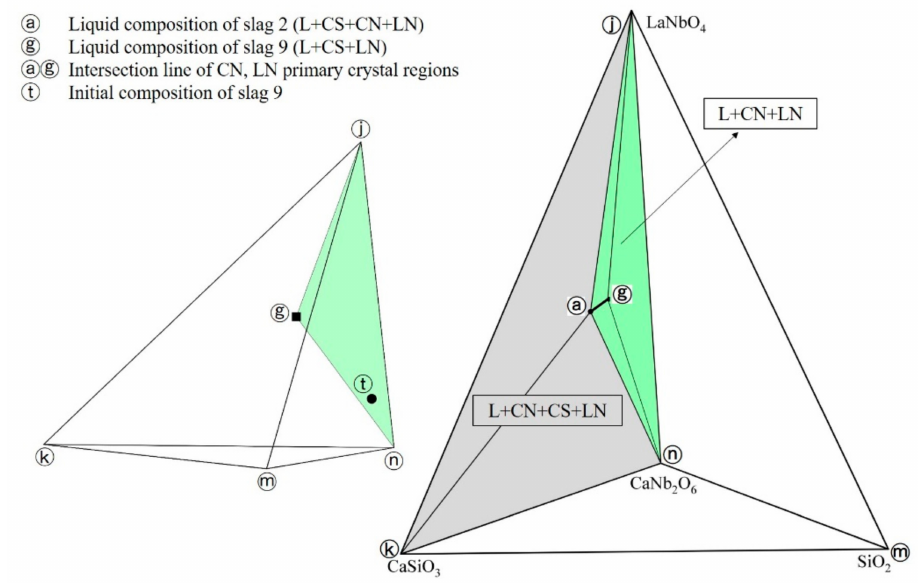
Figure 6. Intersection line of CN, LN primary crystal